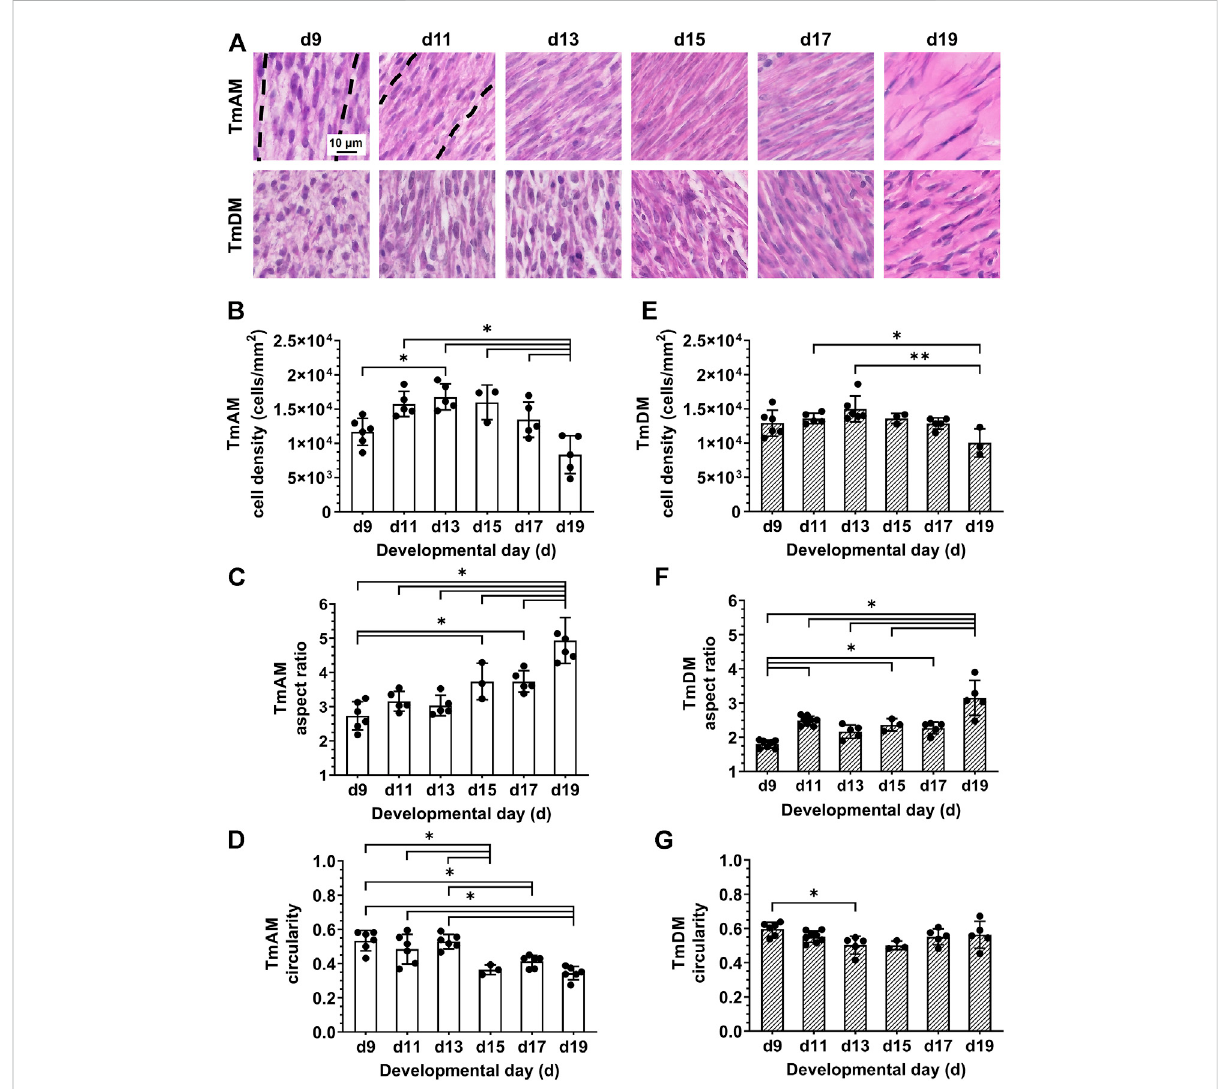
FIGURE 3 Cell density decreased and nuclei became more elongated in jaw-closing TmAM and jaw-opening TmDM between d9 and d19. (A) Representative bright fi eld images of H&E stained TmAM and TmDM. (B) Cell density increased signi fi cantly until d13 and subsequently decreased signi fi cantly until d19 in TmAM. (C) Nuclear aspect ratio increased signi fi cantly between d9 and d19 in TmAM. (D) Circularity decreased signi fi cantly between d9 and d19 in TmAM. (E) Cell density decreased signi fi cantly between d13 and d19 in TmDM. (F) Nuclear aspect ratio increased signi fi cantly between d9 and d19 in TmDM. (G) Circularity decreased signi fi cantly between d9 and d13 in